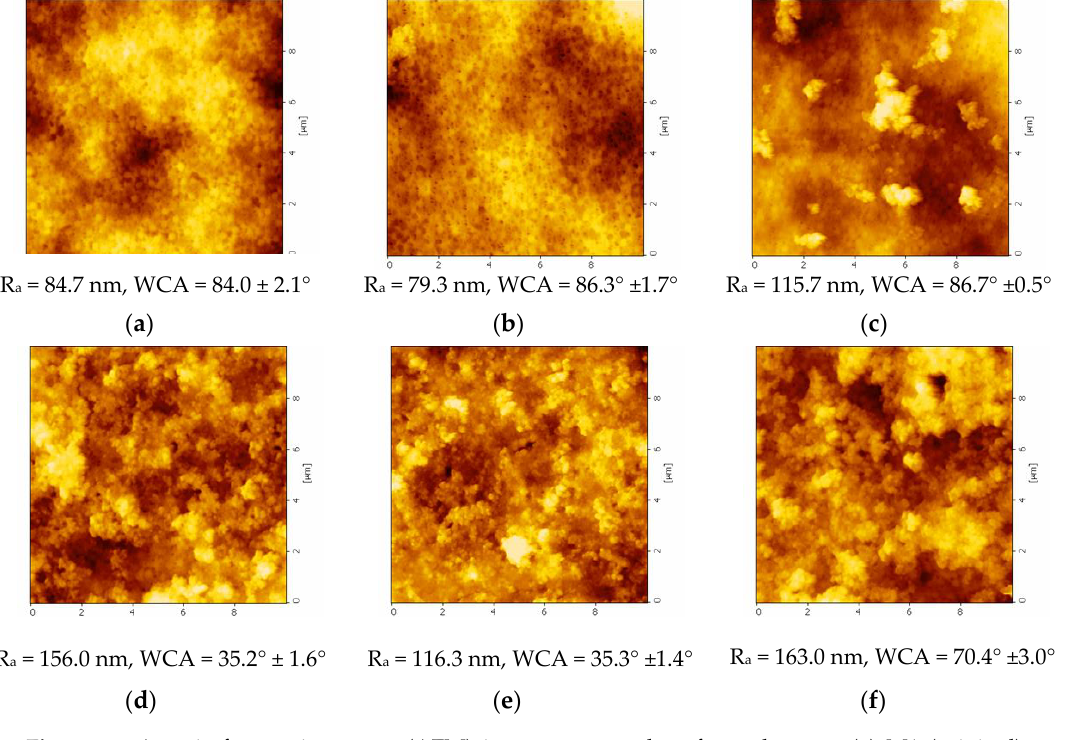
Figure 5. Atomic force microscopy (AFM) image topography of membranes: ( a ) M1 (original); ( b ) M2 (8 h); ( c ) M3 (16 h); ( d ) M4 (24 h) at mixed 10 ppm TiO 2 -NP/10 ppm AgNP and; ( e ) M5 (10 ppm TiO 2 -NP/20 ppm AgNP); and ( f ) M6 (20 ppm TiO 2 -NP/10 ppm AgNP) at coating time of 24 h.